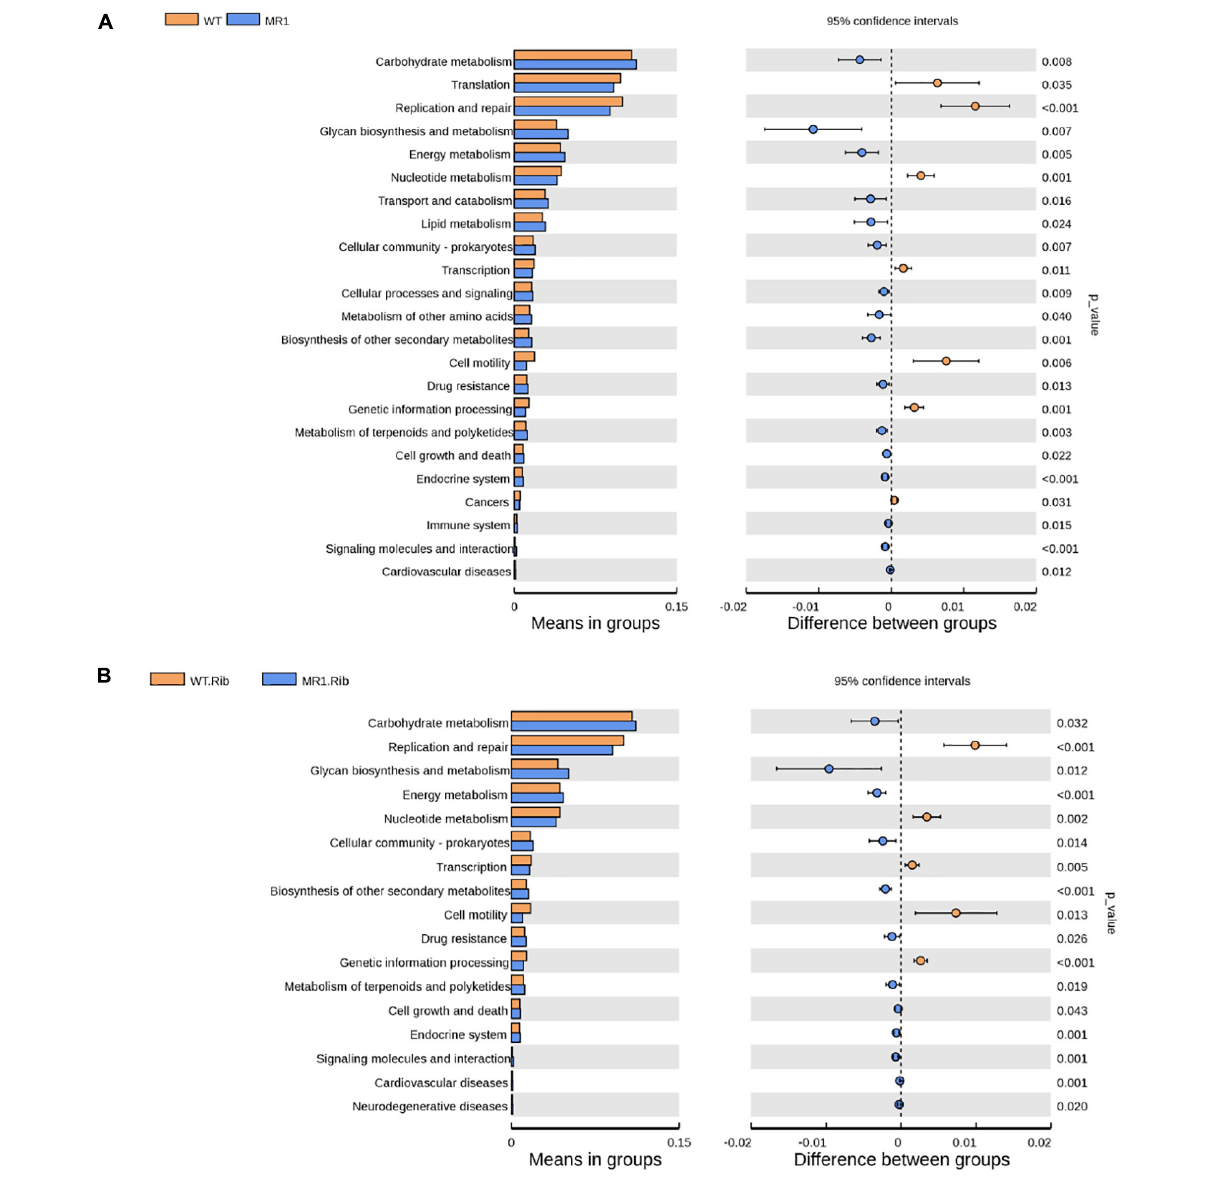
FIGURE 7 | Differences in the abundances of KEGG pathways inferred by PICRUSt2. The abundances of the KEGG pathways encoded by the gut microbiota of the WT and MR1 − / − mice (A) and the riboflavin-pretreated WT and MR1 − / − mice (B)